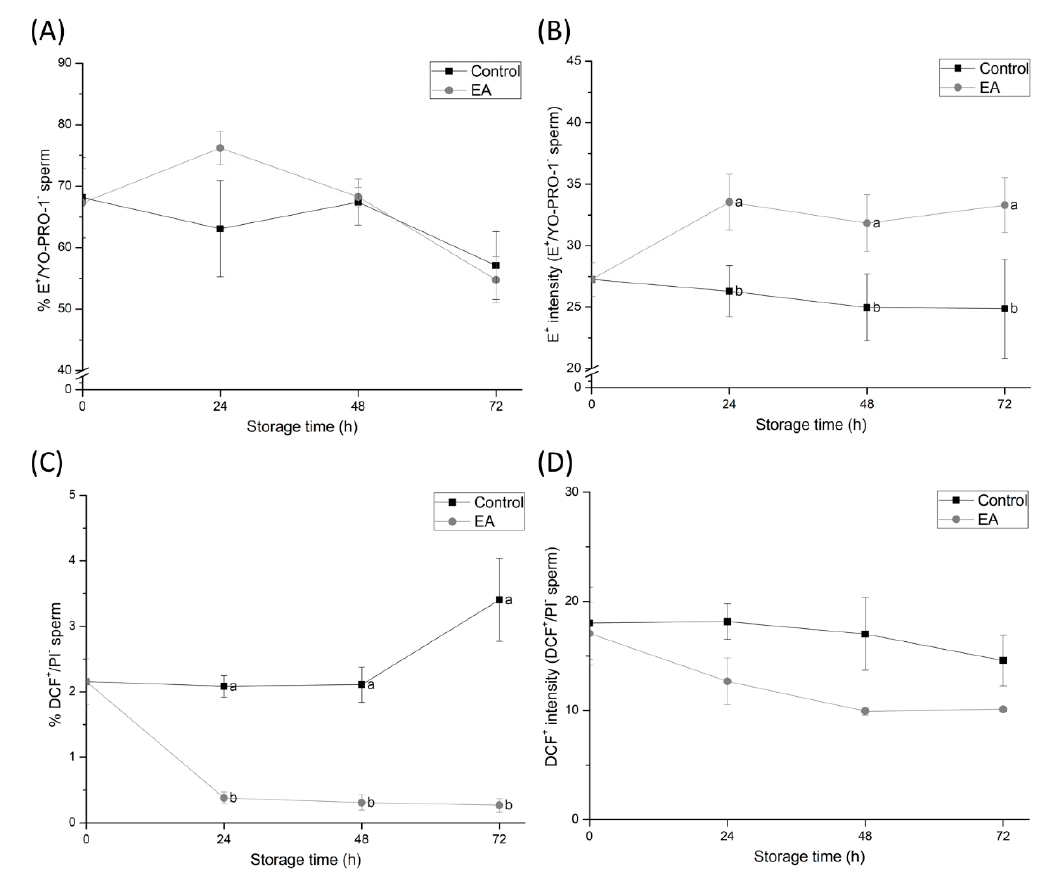
Figure 4. ( A ) Percentages of viable spermatozoa showing high superoxide (O 2- •) levels (E + /YO-PRO- Figure4. ( A )Percentagesofviablespermatozoashowinghighsuperoxide(O 2- • )levels(E + / YO-PRO-1 − 1 − ), ( B ) mean E + fluorescence intensity of viable spermatozoa showing high superoxide levels, ( C )